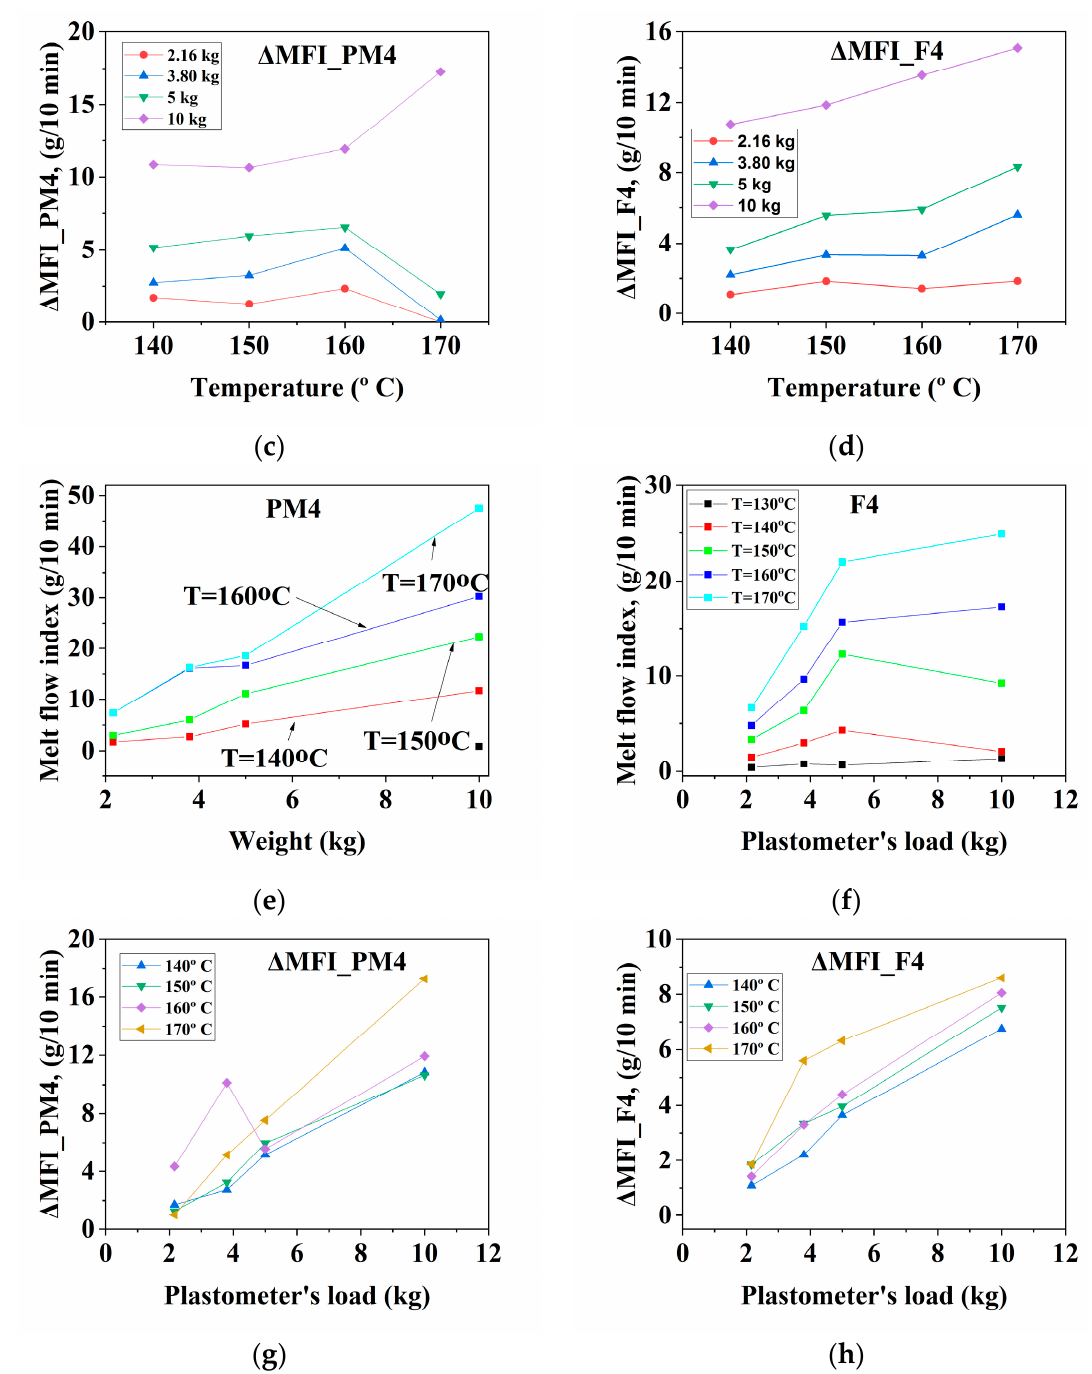
Figure 4. The melt rheological properties of the recycled PM4 compound ( a – d ) with those of the primary F4 ( e – h ) and their dependence on the flow conditions (for PM4: ( a ) MFI = f(T); ( b ) Δ MFI = f(T); ( c ) MFI = f(G); ( d ) Δ MFI = f(G)); (for F4: ( e ) MFI = f(T); ( f ) Δ MFI = f(T); ( g ) MFI = f(G); ( h ) Δ MFI = f(G)).